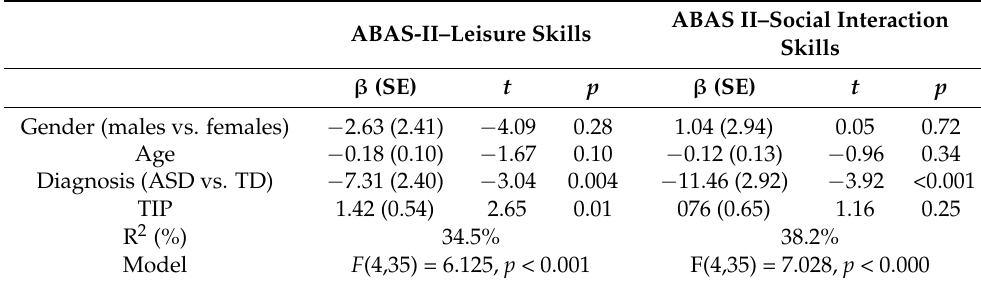
ABAS II–Social Interaction Skills